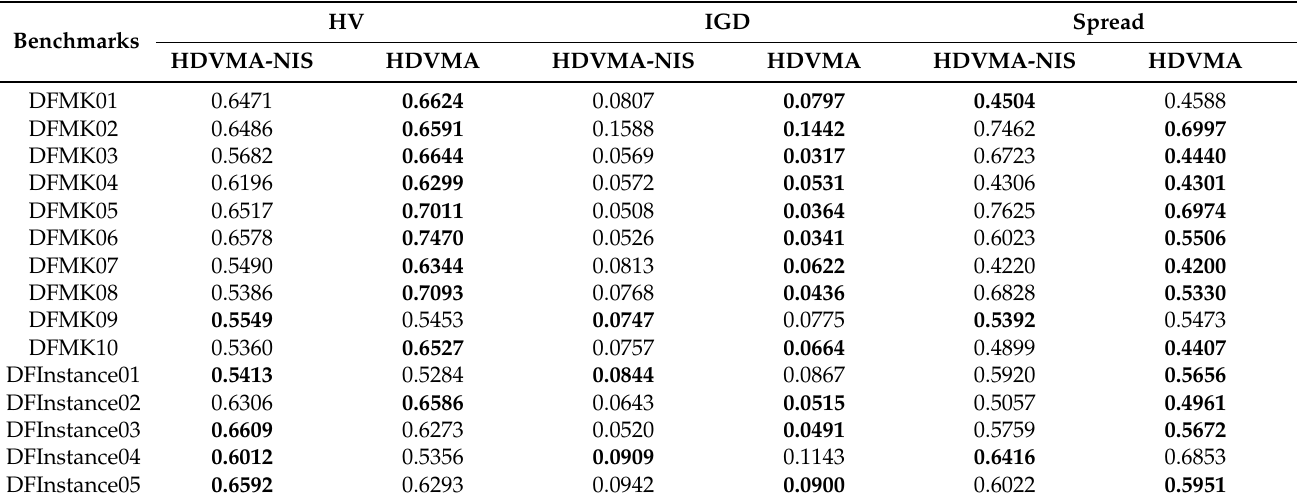
Table 5. Comparison of initialization